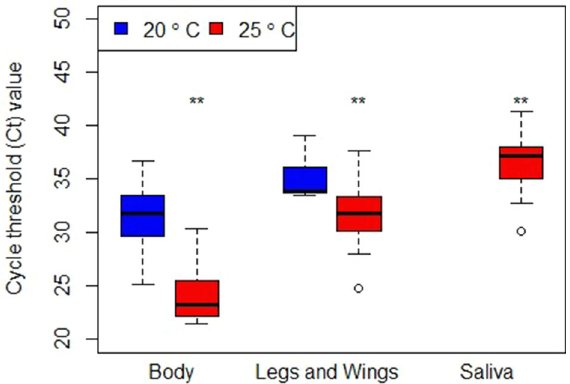
Figure 2. Cycle threshold ( ct ) values for recovered JEV RNA from Cx. pipiens body (n = 39 and 18), leg/wing (5 and 14) and saliva samples (0 and 14) in both the 20 °C and 25 °C treatments respectively, significant differences between temperature treatments have been marked with a double asterisk. Viral RNA was only recovered from the saliva of mosquitoes in the 25 °C treatment, suggesting that these mosquitoes were competent to transmit